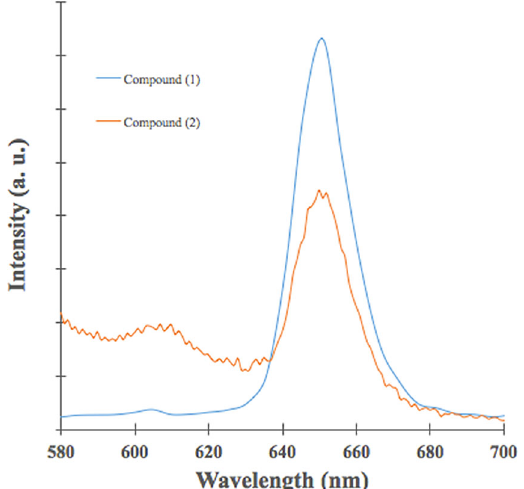
Figure 3. Emission spectra of (1) and (2).